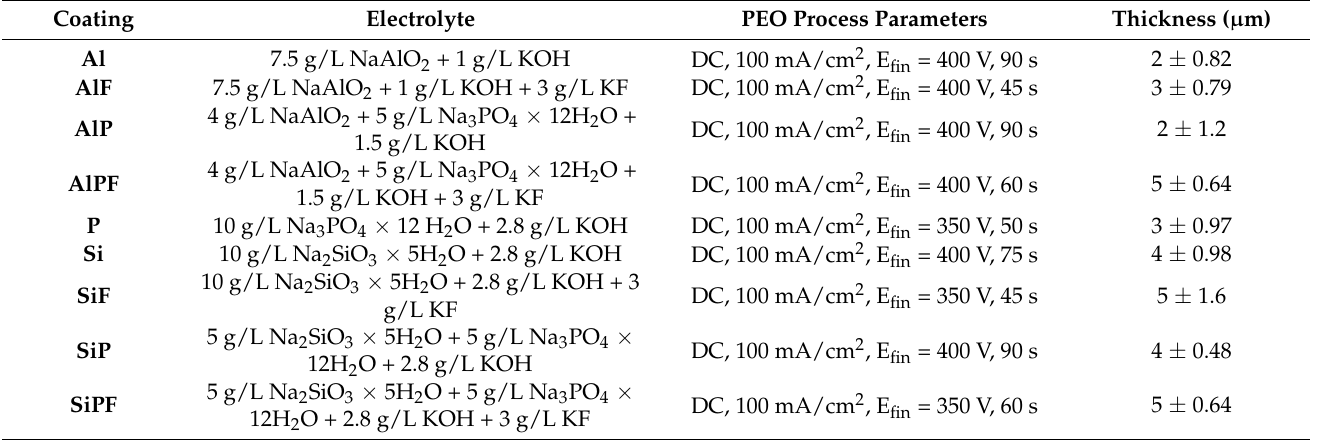
Table 1. Summary of PEO treatment parameters and resulted coatings’